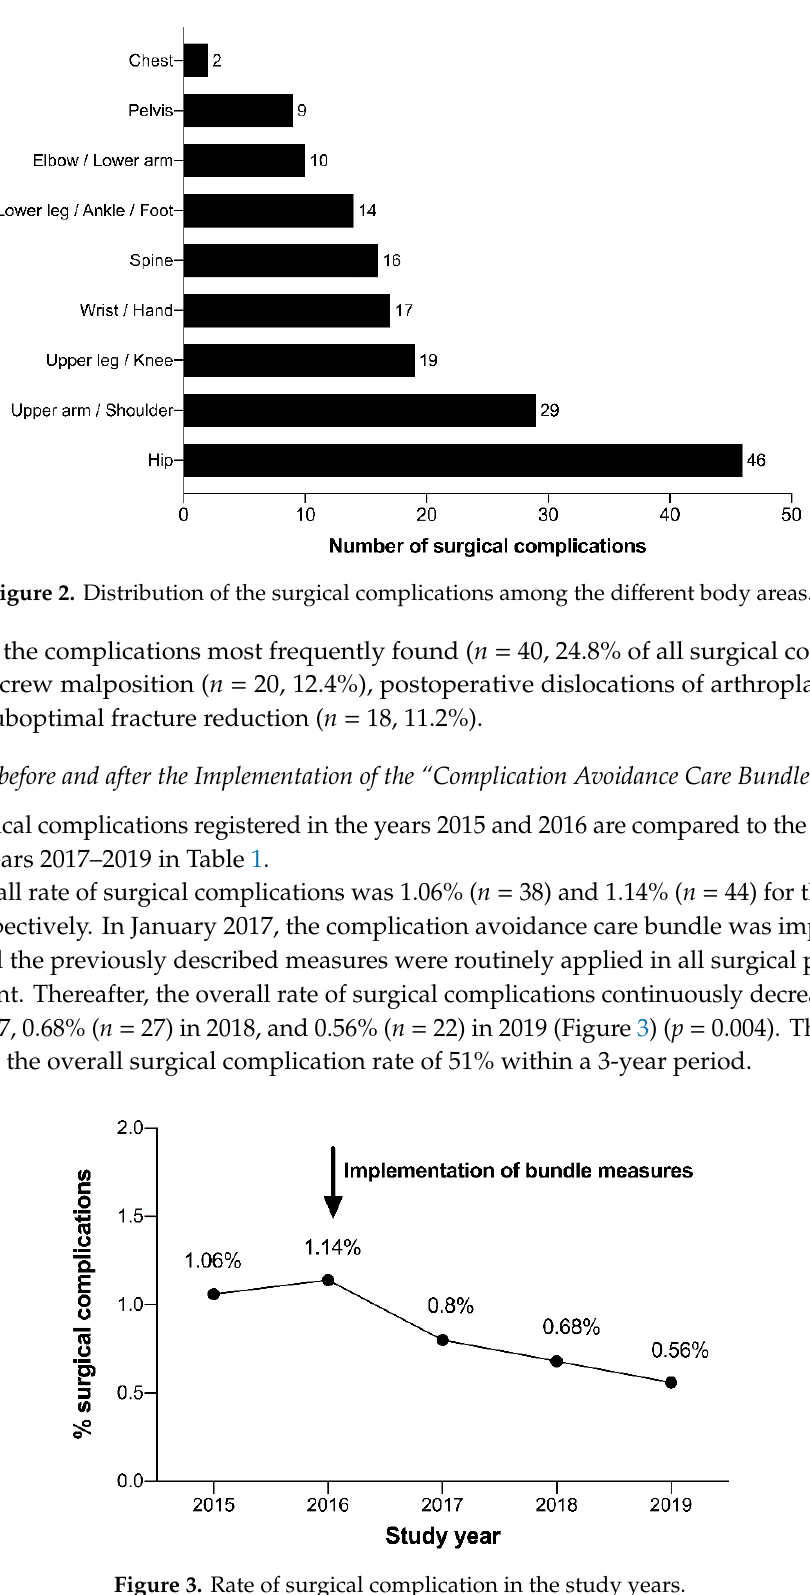
Figure 3. Rate of surgical complication in the study years .